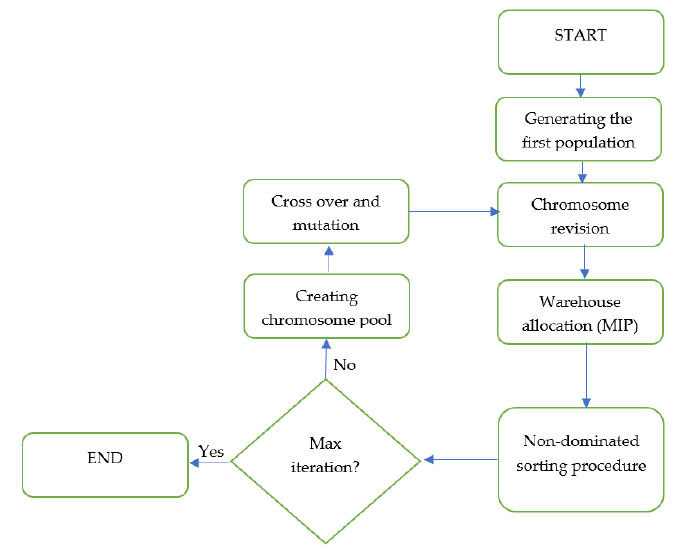
Figure 3. The matheuristic algorithm.